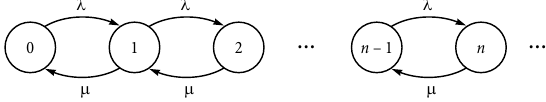
Fig. 3. The flow diagram for the